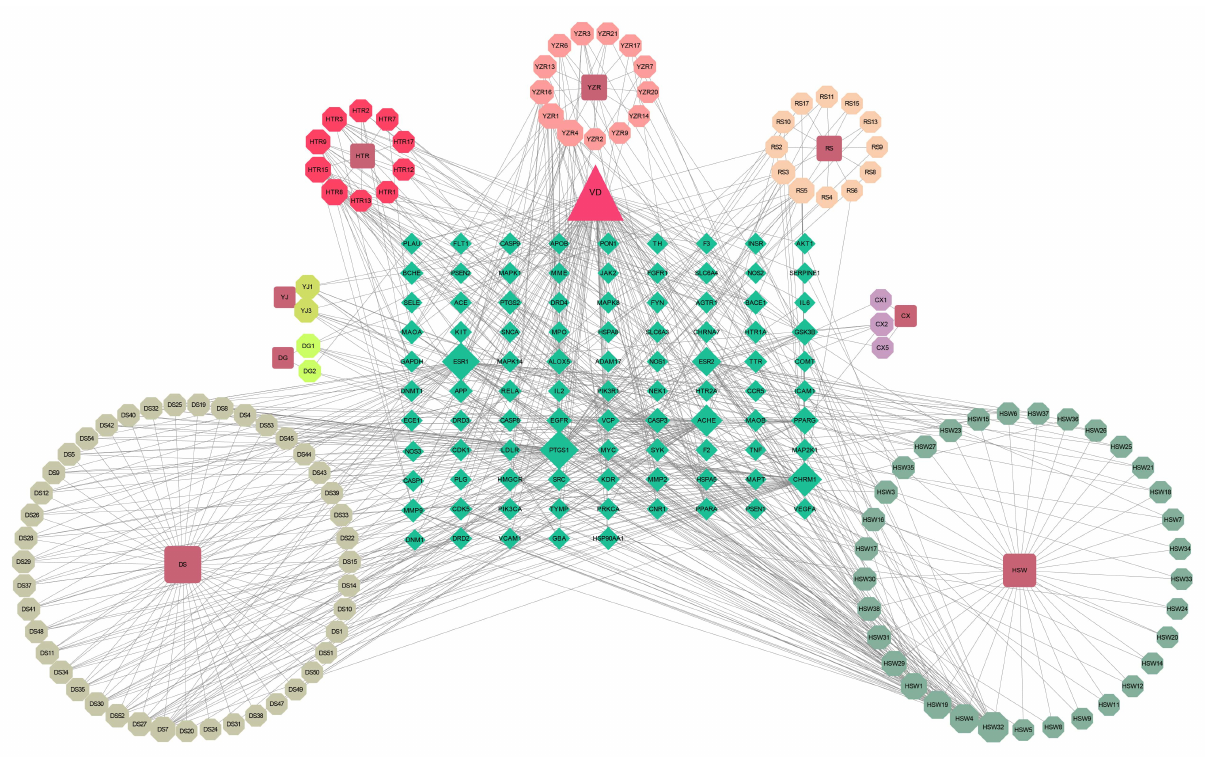
Fig. 2. Network of BSHXF-component-target. The octagon represents the compound target of the drug, the triangle represents the disease, and the diamond represents the disease target.